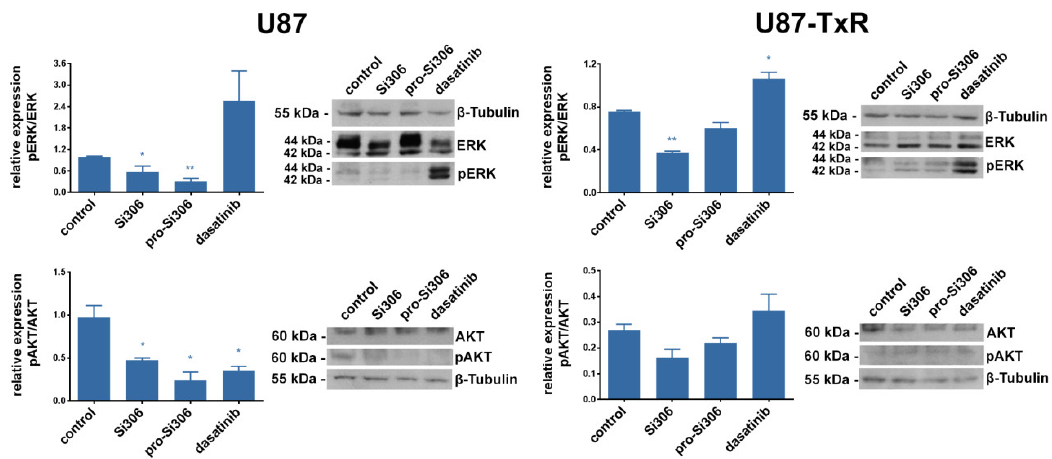
Figure 6. Si306 and pro-Si306 inhibit the activity of Src downstream signaling pathway components in GBM cell lines. Representative Western blot images of pERK, extracellular signal-regulated kinase (ERK), pAKT and protein kinase B (AKT) protein expression in U87 and U87-TxR cells after 24 h treatment with 5 µ M Si306 and pro-Si306 are shown. Histograms represent Western blot data expressed as phosphoprotein level relative to total protein level, normalized to β -tubulin. Values are expressed as mean ± SEM ( n = 3). Statistical significance between treated and control group is shown as * ( p < 0.05), ** ( p < 0.01), and *** ( p < 0.001), uncropped western blot in Figure